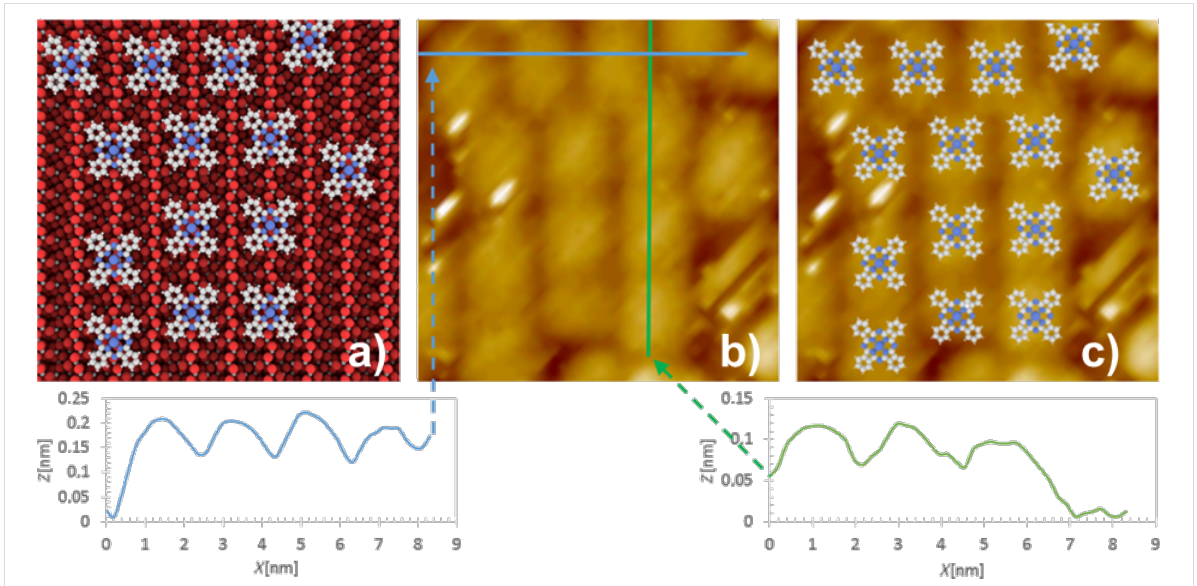
Figure 2: Geometrical characterization of 0.9 ML of ZnPc molecules on the TiO 2 (011)-(2×1) surface. (a) Illustration of the model of ZnPc molecule locations on the substrate closely reproducing the molecular contrast of the STM images; (b) and (c): high resolution empty state STM images (9×9 nm 2 ) taken at RT. The linear profiles taken along [01 − 1] and [100] directions are shown below the STM images. The overlay of molecule loca- tions with the STM image is shown in (c). STM scanning parameters are: I = 3 pA, U = 2.3